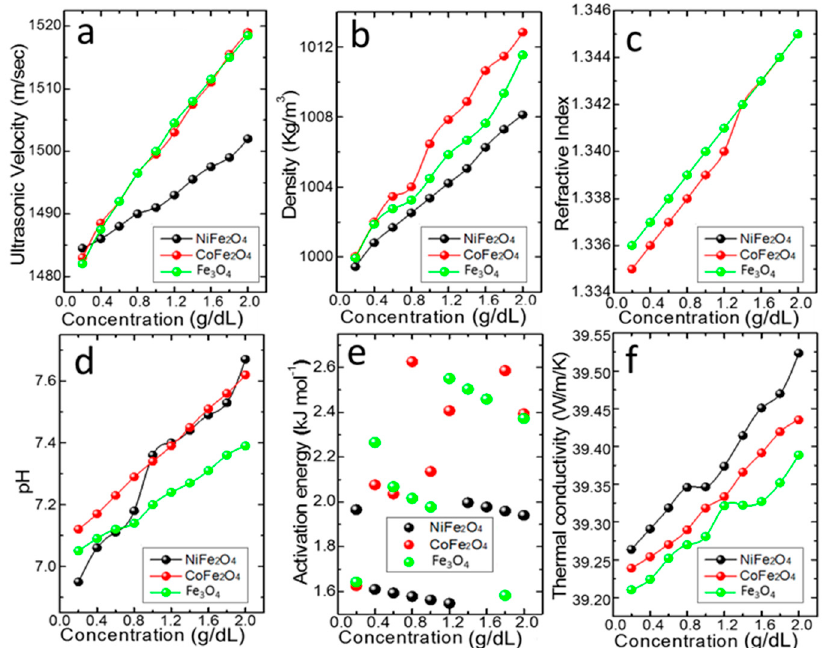
Figure 5. Thermophysical properties of the as-designed magnetic nanofluids. ( a ) Ultrasonic velocity, ( b ) Density, ( c ) Refractive Index, ( d ) pH, ( e ) Activation energy and ( f ) Thermal conductivity